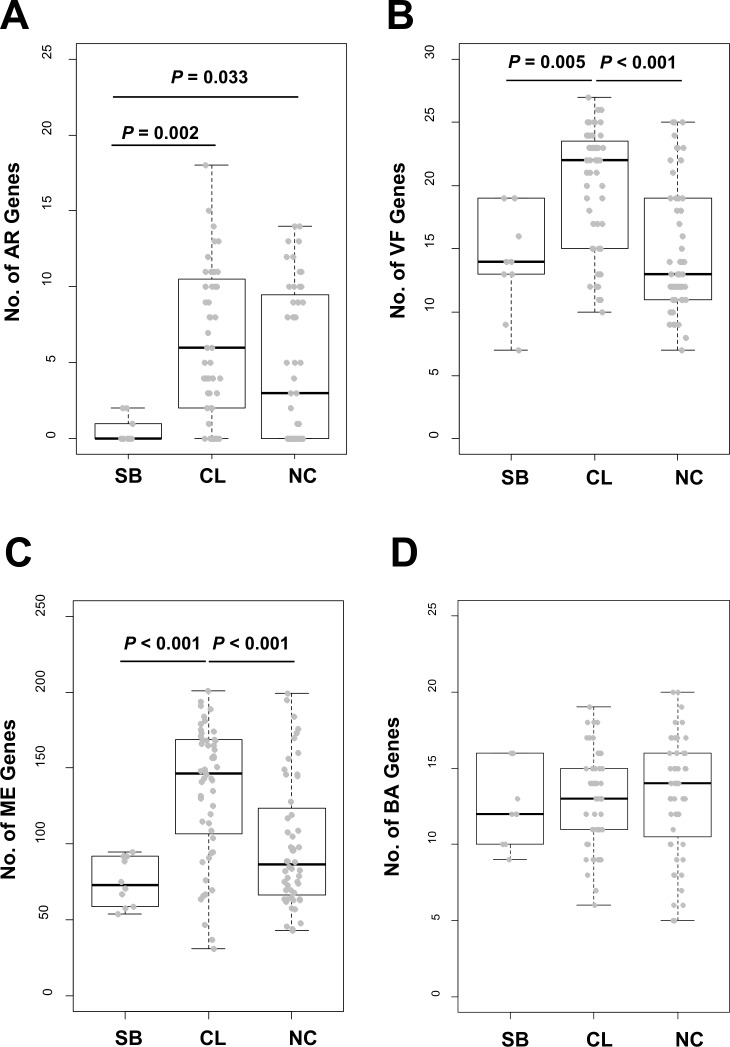
Frequencies of AR, VF, ME, and BA genes.Frequencies of four types of genes, AR (A), VF(B), ME (C) and BA (D), were compared among soybean (SB), clinical (CL) and non-clinical (NC) groups. Statistical significance was examined using Tukey's HSD (Honestly Significant Difference). Non-significant comparisons were omitted (P>0.05). Each gray spot indicate a single E. faecium strain.